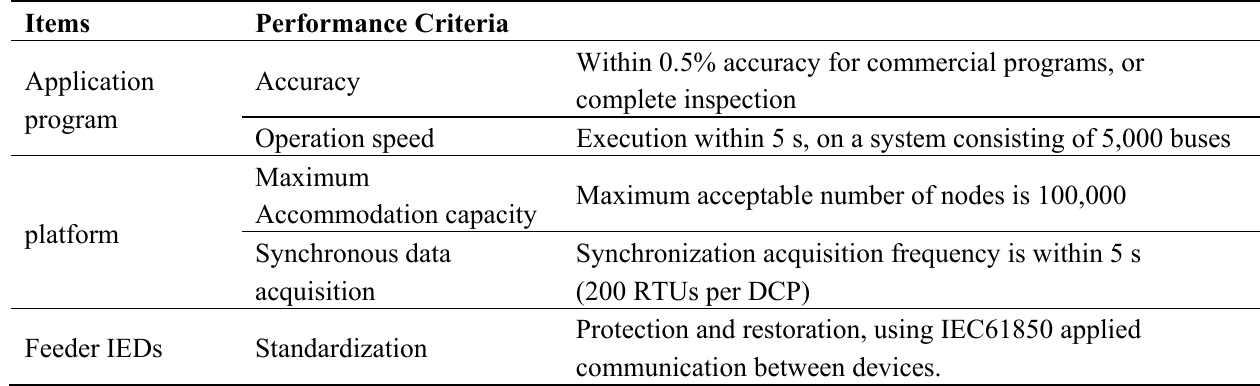
Table 5. Performance criteria of the KSDMS